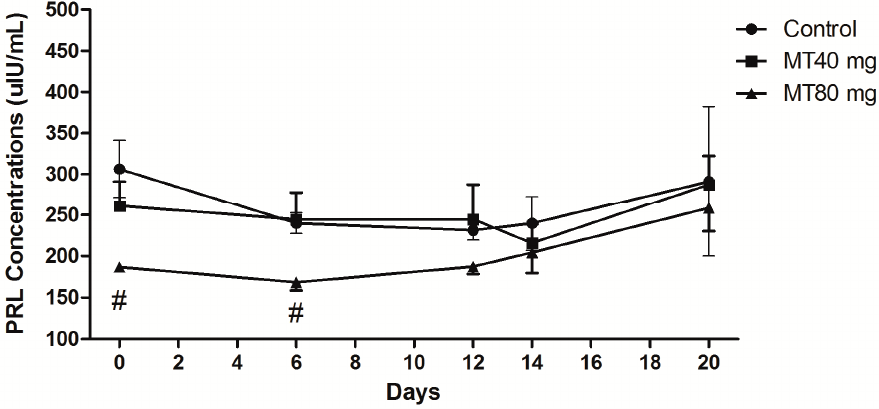
Figure 4. PRL concentrations throughout the study period. Day 0: CIDR insertion;